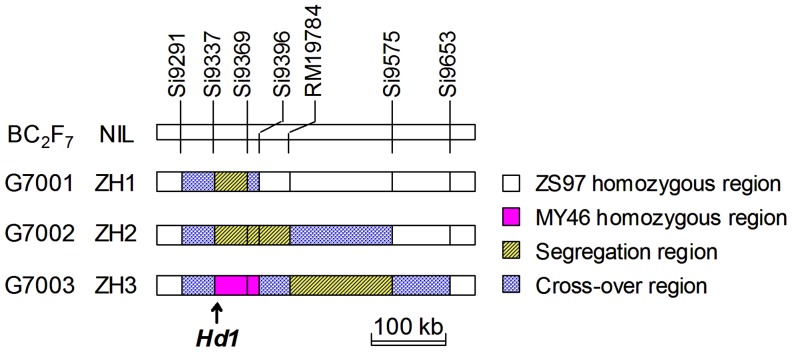
Genotypic composition of the BC2F7 populations and NILs in the target region.